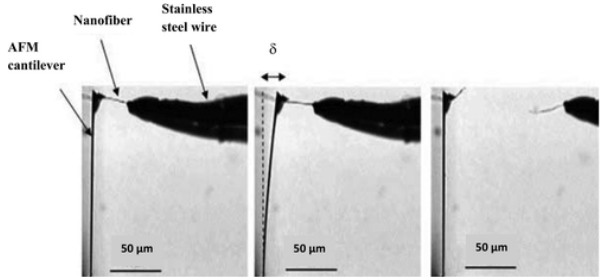
Figure 12. Tensile test of single-electrospun nylon-6,6 nanofiber up to fracture. Reprinted from [115] with permission from John Wiley and Sons.